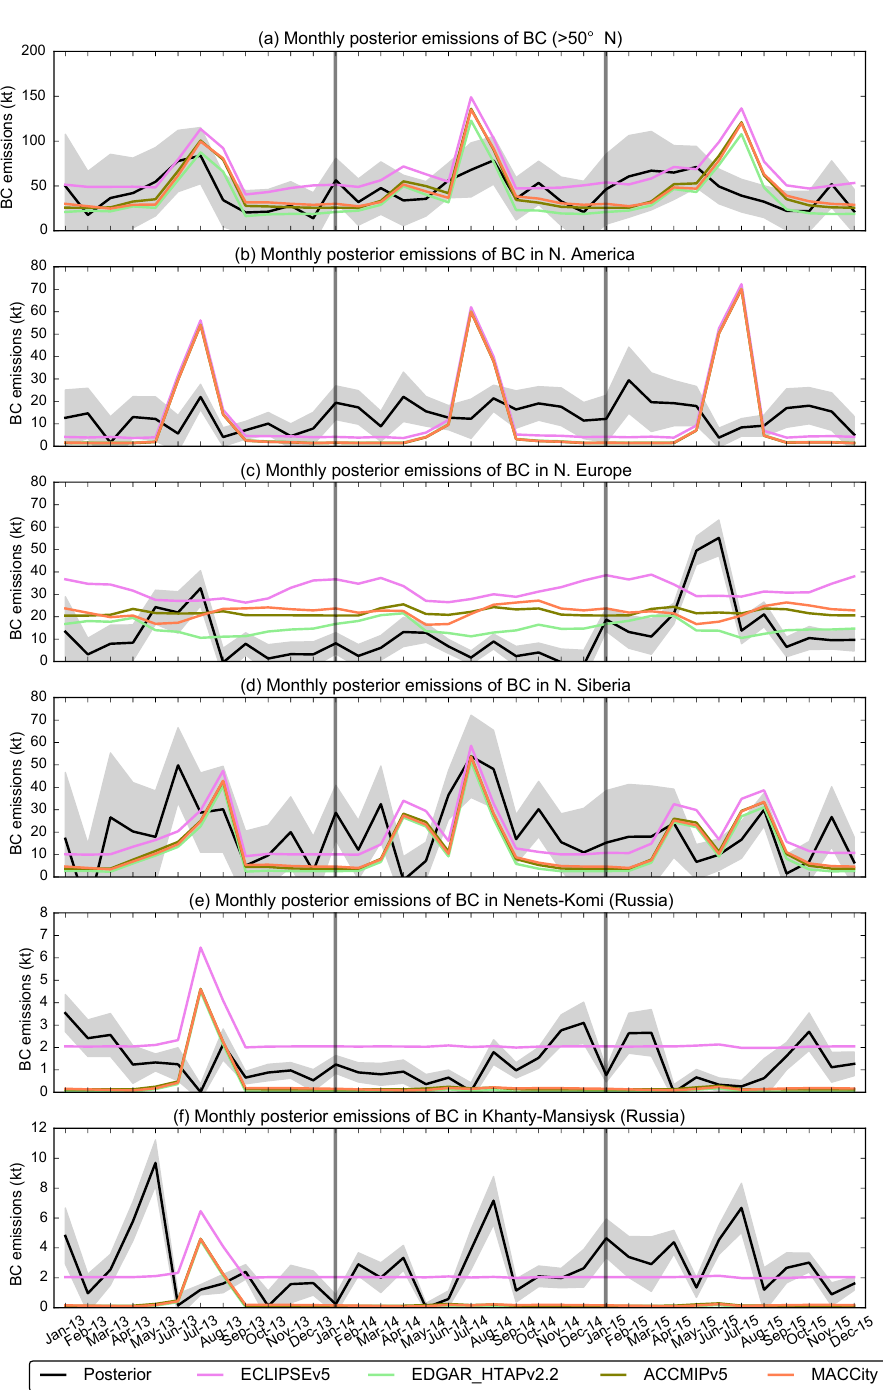
Figure 13. Monthly posterior emissions of BC shown for all regions located (a) >50 ◦ N, (b) in North America (>50 ◦ N), (c) in northern Europe (>50 ◦ N), (d) in northern Siberia (>50 ◦ N), (e) in Nenets–Komi oblast (>50 ◦ N, Russia) and (f) in Khanty-Mansiysk oblast (>50 ◦ N, Russia) for the 2013–2015 period. Monthly prior emissions of BC from ECLIPSEv5, EDGAR_HTAPv2.2, ACCMIPv5 and MACCity emissions inventories are also shown for the same regions and time period. The uncertainty of the posterior emissions of BC stems from the use of different scavenging coefficients and different prior emission datasets (see Sect.